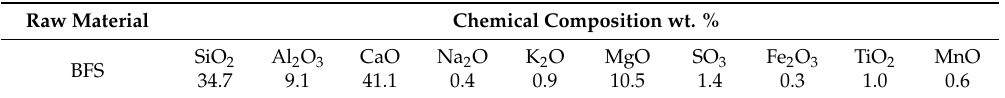
Table 1. Chemical composition of BFS as determined by